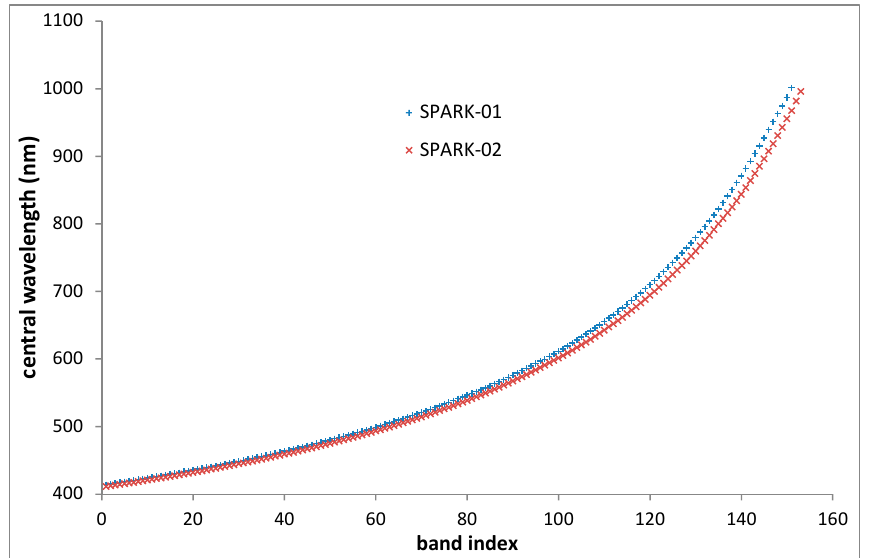
Figure 2. Central spectral wavelengths of various SPARK-01 and -02 bands.